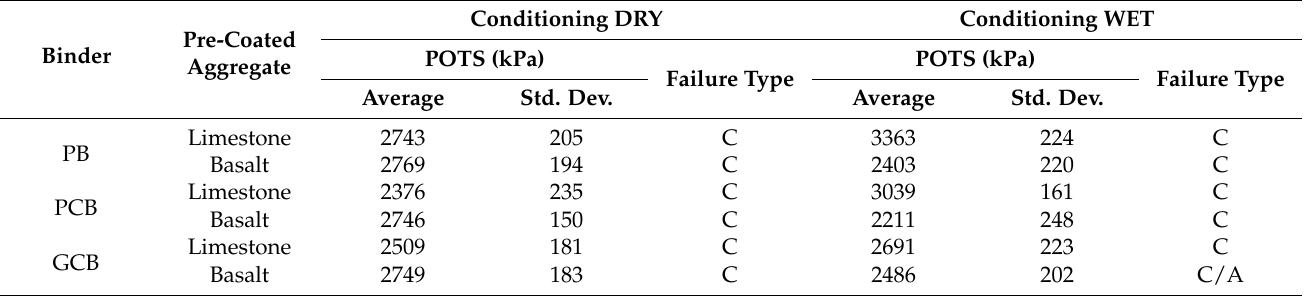
Table 9. BBS testing results for systems with pre-coated